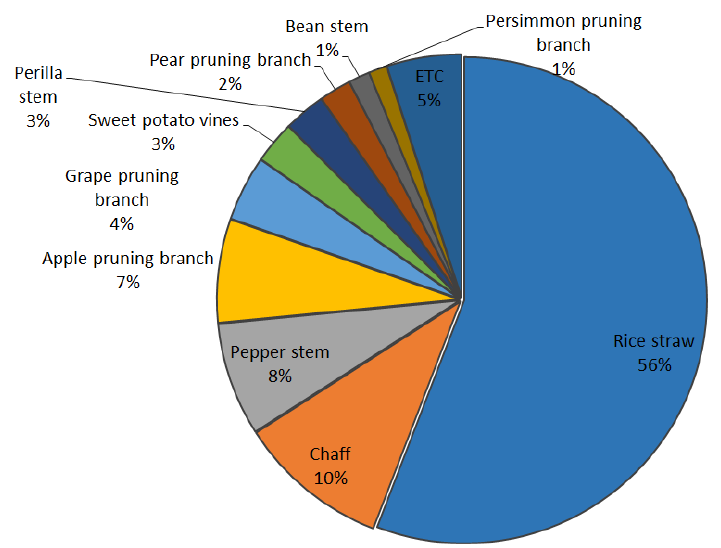
Figure 1. Annual agricultural by-product potential in Korea.